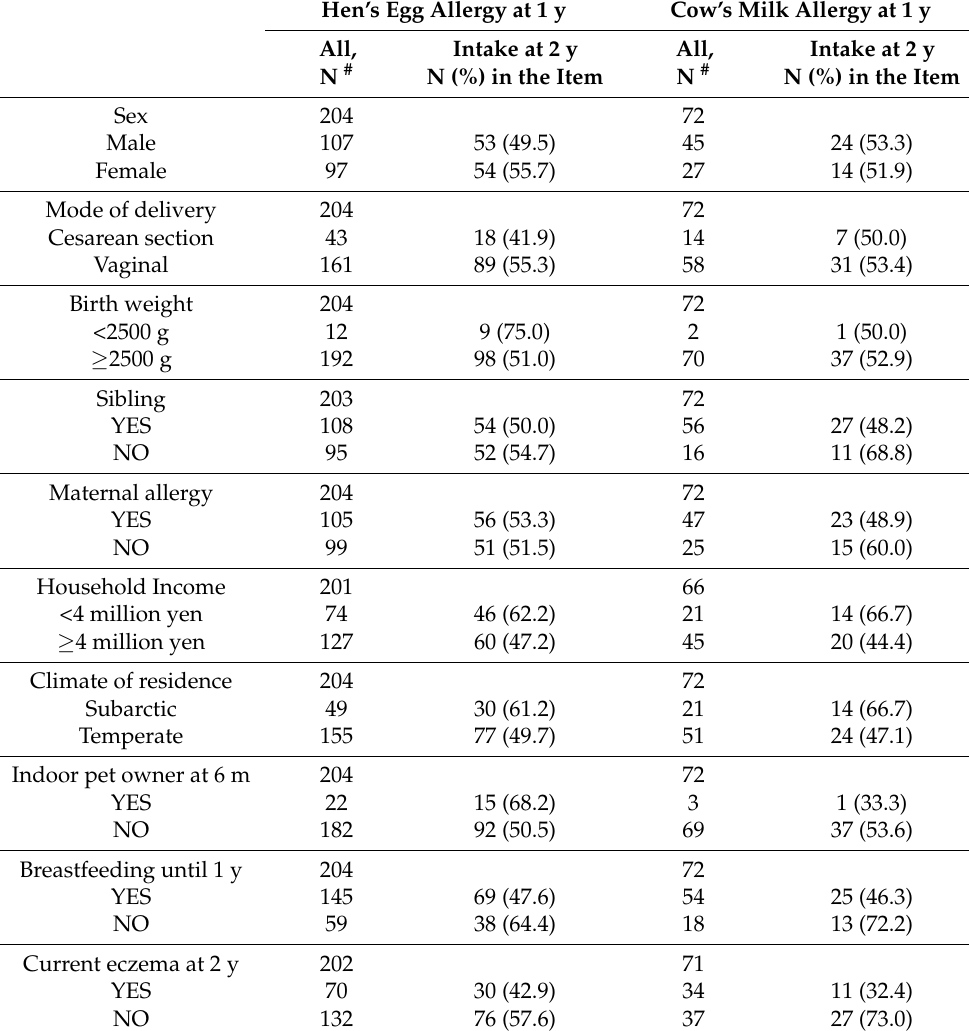
Table 1. Characteristics of children in this